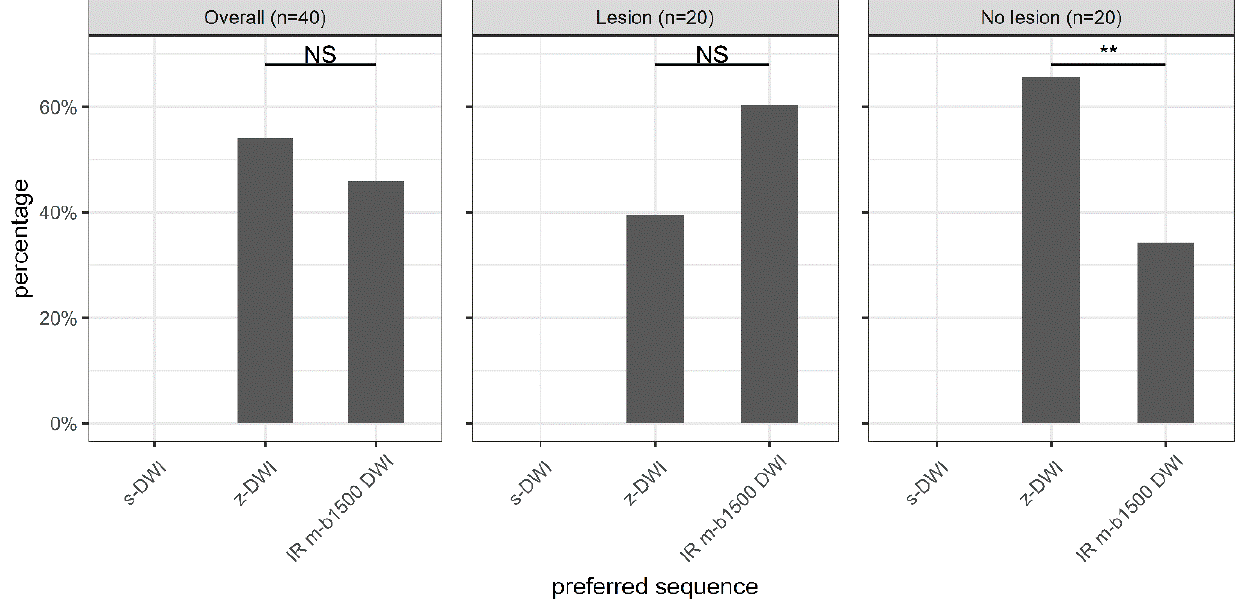
Figure 1. Zoomed diffusion-weighted imaging (DWI) with spectral-attenuated inversion-recovery fat saturation (z-DWI) was the preferred sequence overall, although not significantly. Significant differences in preference were observed only in the absence of a lesion, where DWI with improved inversion-recovery fat saturation (IR m-b1500 DWI) was preferred. s-DWI: single-shot echo-planar DWI. NS = p > 0.05. ** = 0.001 < p ≤ 0.01.